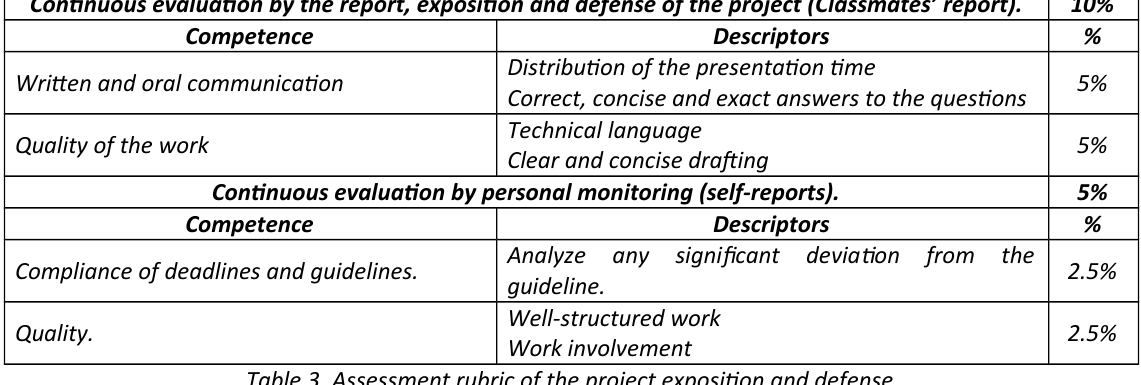
Table 3. Assessment rubric of the project expositon and